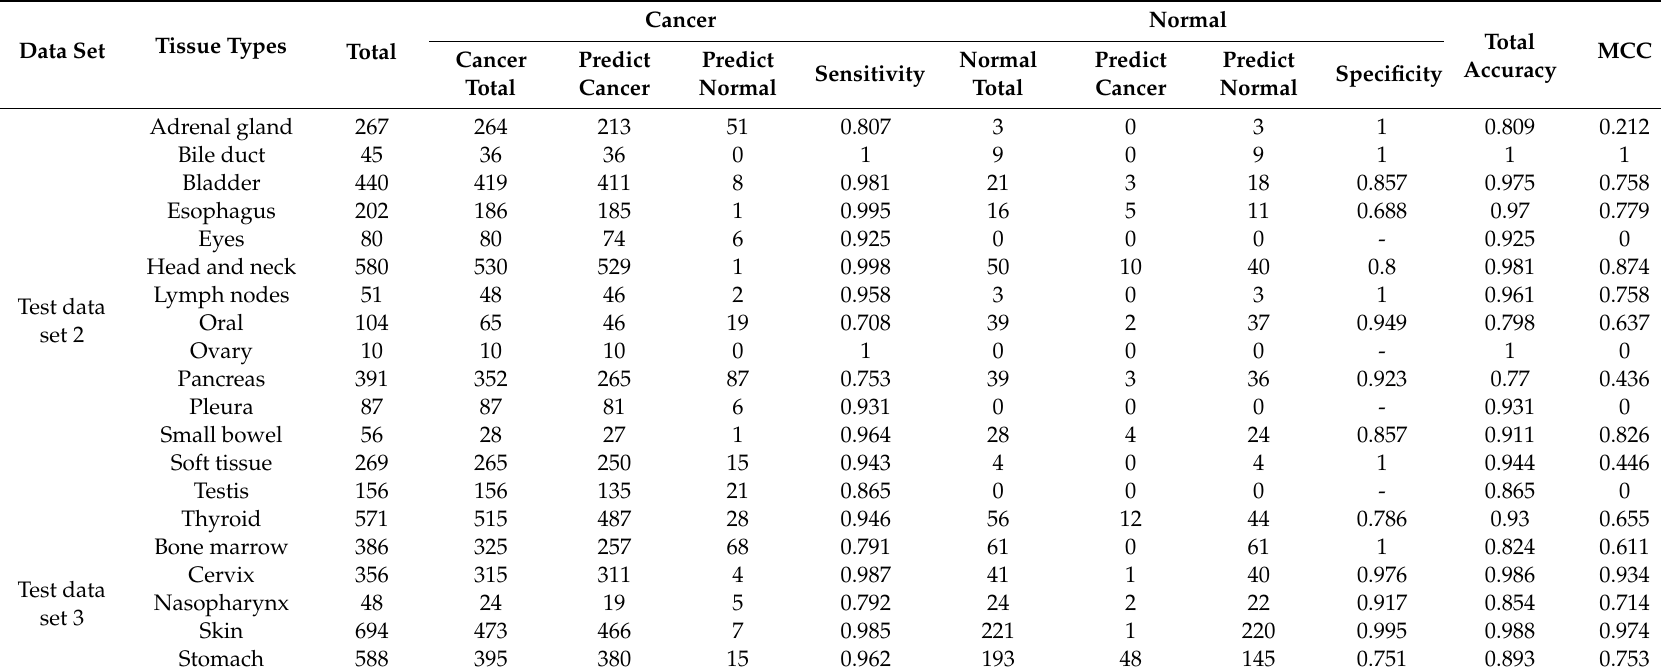
Table 6. The prediction results of two test data sets for 12 CpG